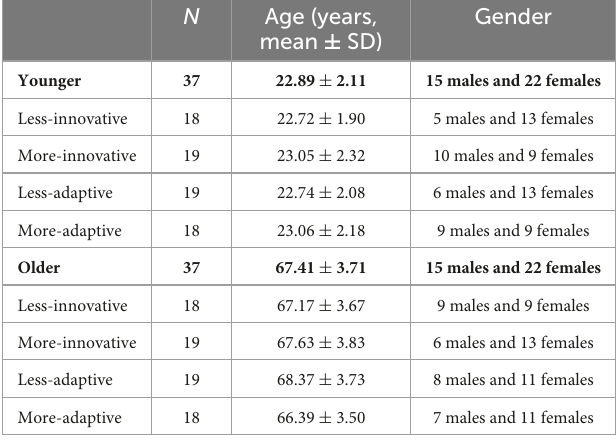
TABLE 2 The demographic data of participants based on age, and assessed innovative and adaptive